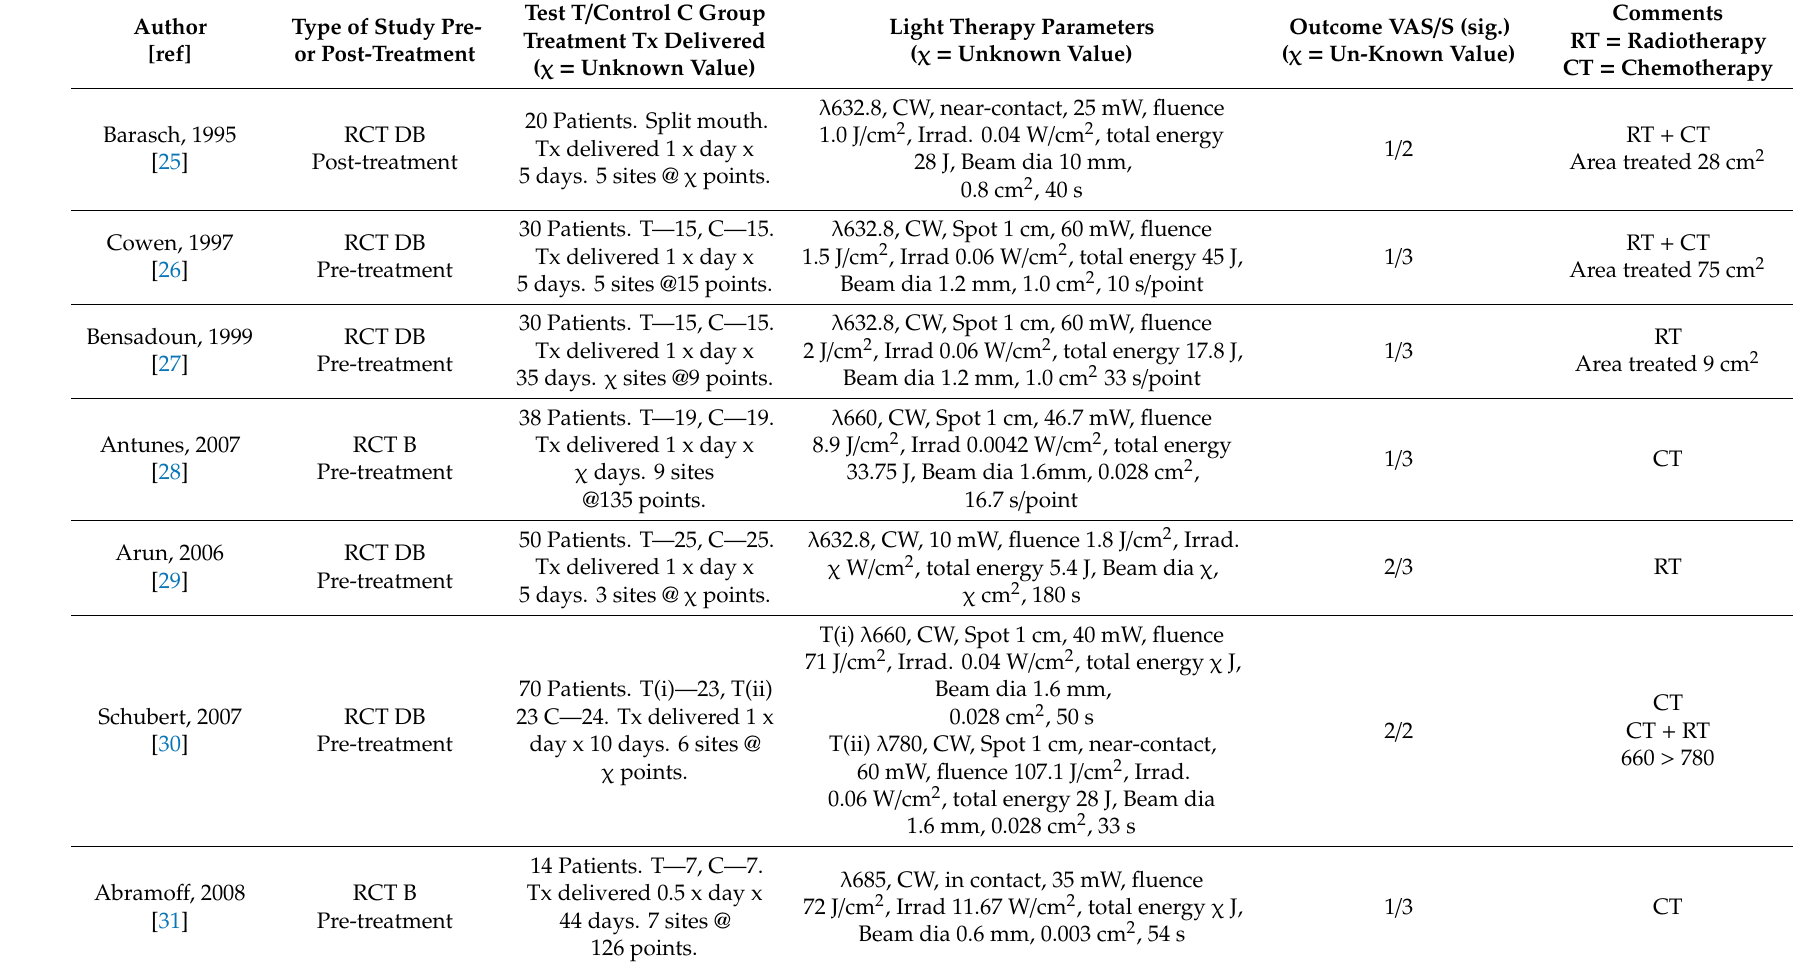
Table 1. Published articles by name and reference with associated